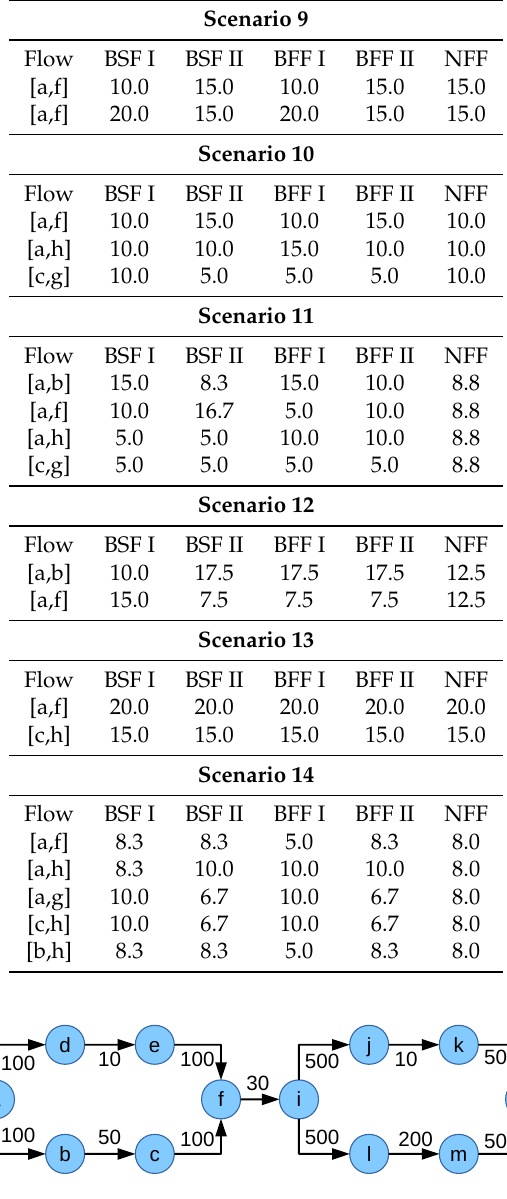
Table 4. Flow set and LP results for the flows’ end-to-end throughput for scenarios 9 to 14 described in Figure 15. All values in Mbps.